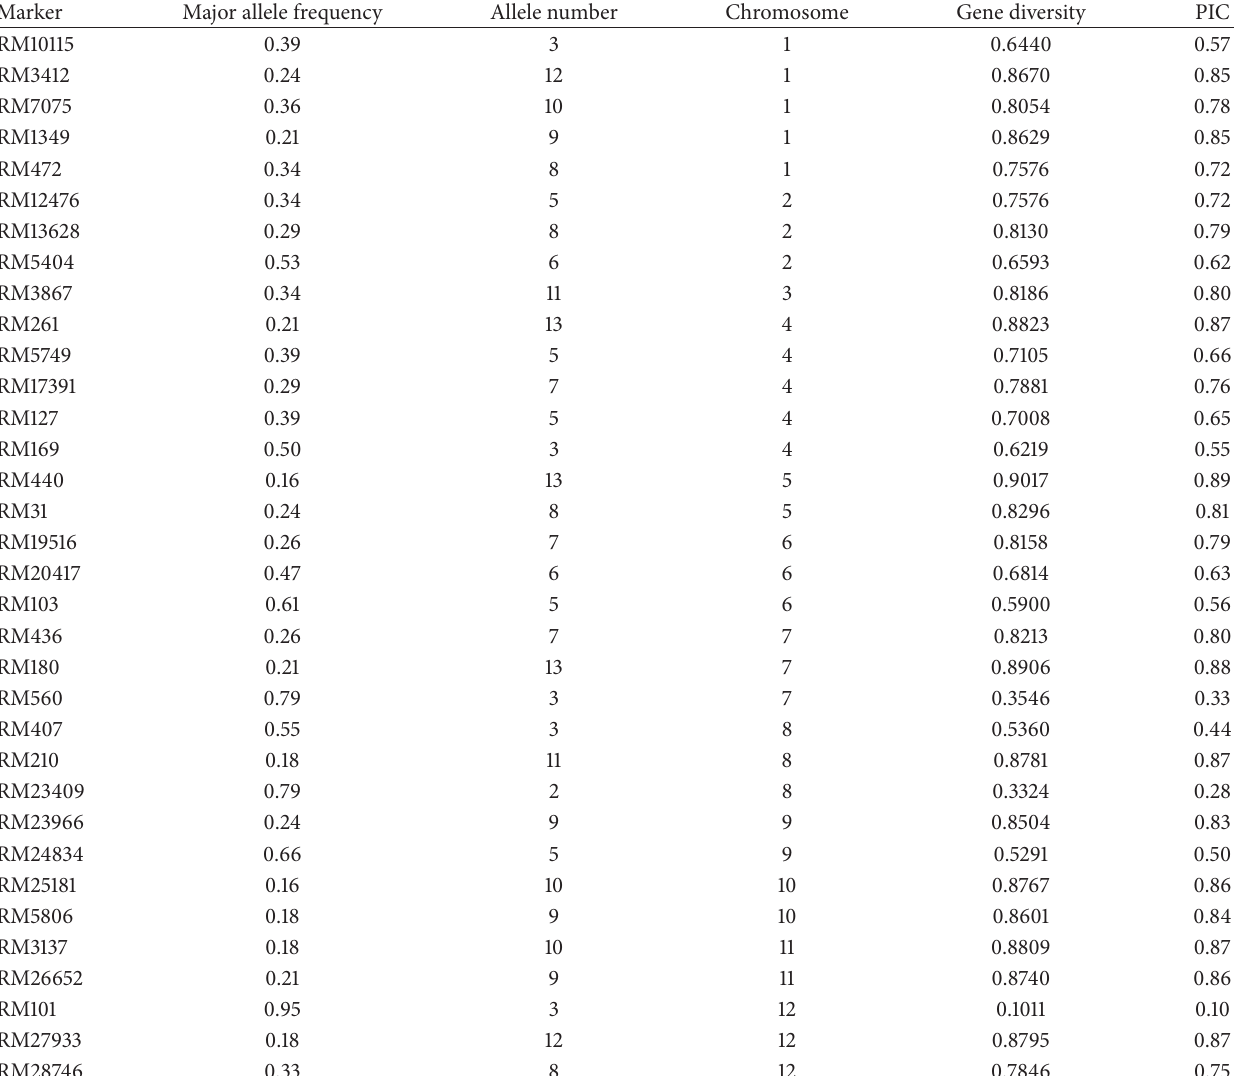
Table 2: Polymorphism information content of different SSR